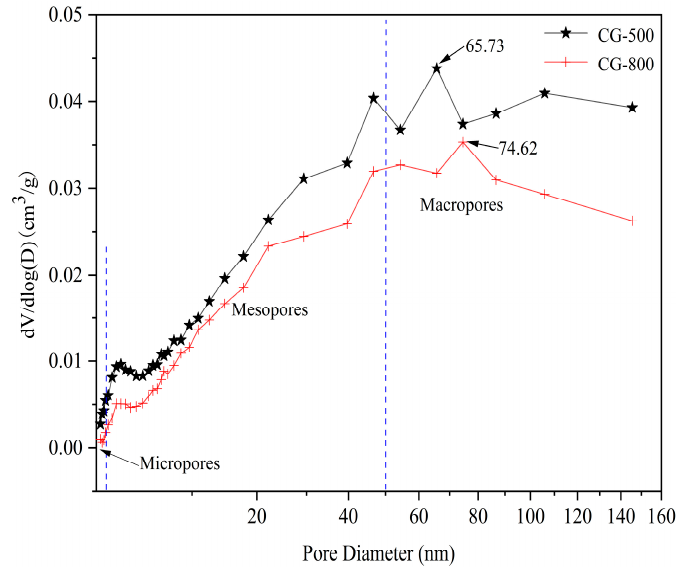
Figure 10. Pore size distribution concerning volume for the CG-500 sample (calcined at 500 °C) and CG-800 sample (calcined at 800 °C).